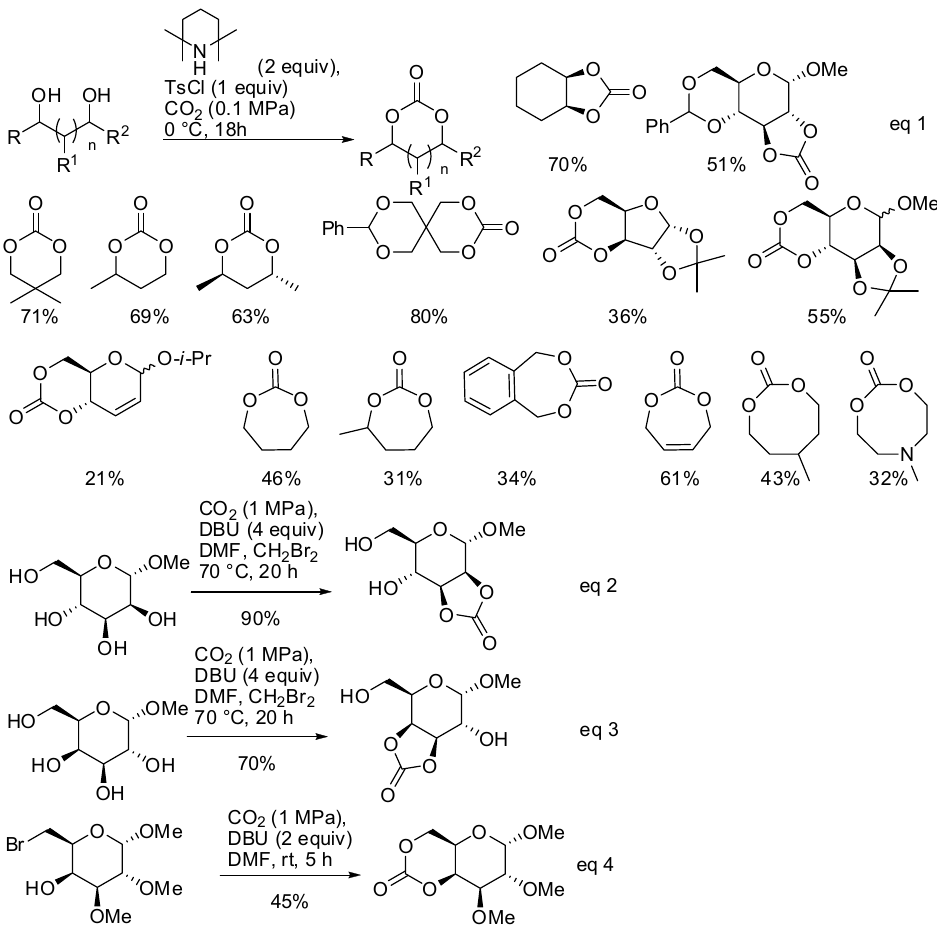
Scheme 12. Synthesis of 5-, 6-, 7- and 8-membered cyclic carbonates.